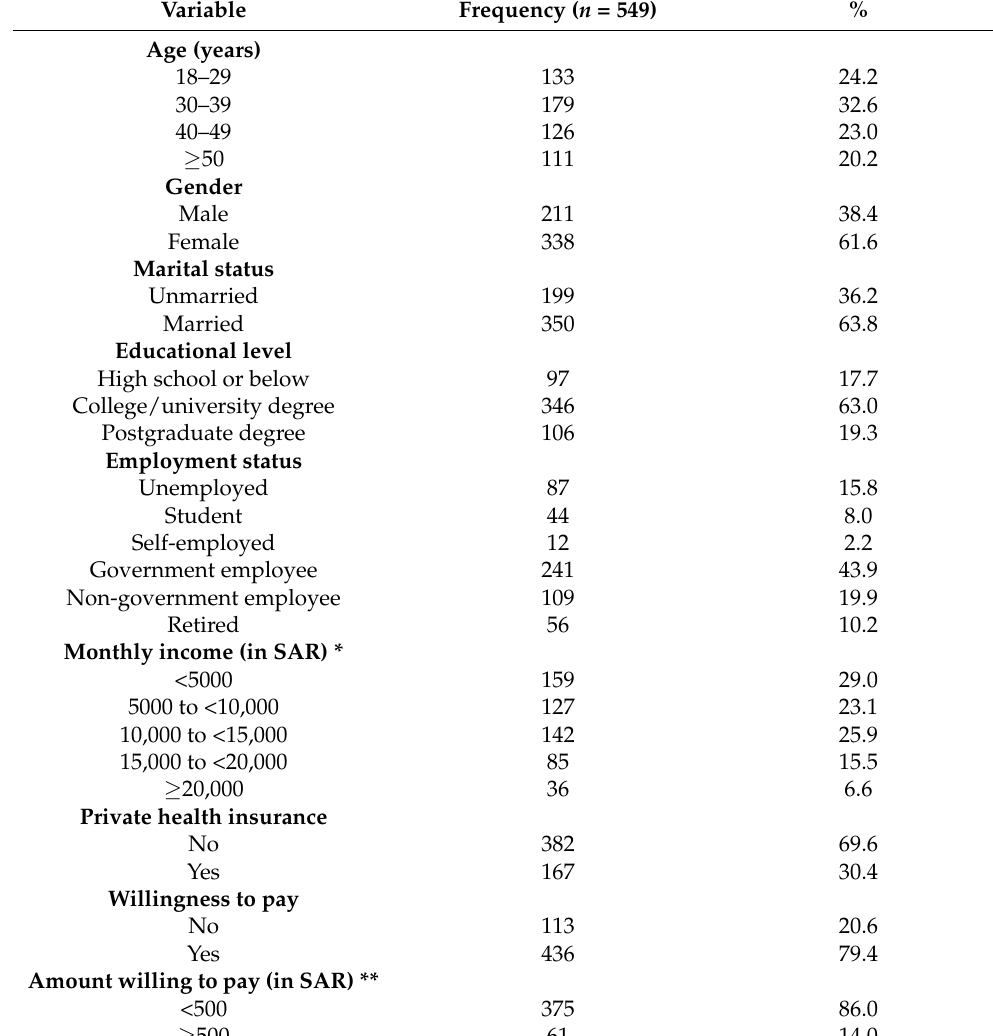
Table 1. Socioeconomic characteristics of